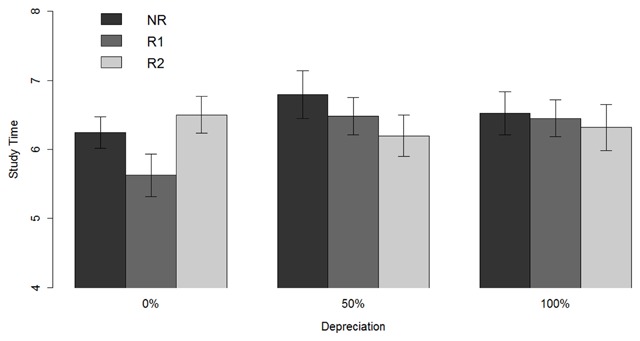
Mean study-time investments. Mean study-time investments for NR (single exam), R1 (first exam with resit opportunity), and R2 (resit exam) per depreciation condition (0%, 50%, or 100%). With depreciation, the total R2 time presented corresponds to the objective R2 investment (i.e. the R2 investment without the addition of the depreciated R1 investment).